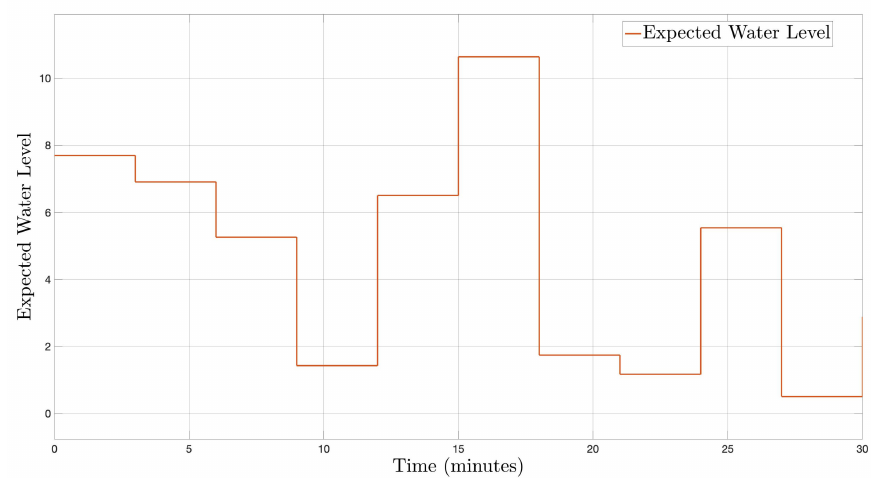
Figure 12. Expected Water Level Under Regular.